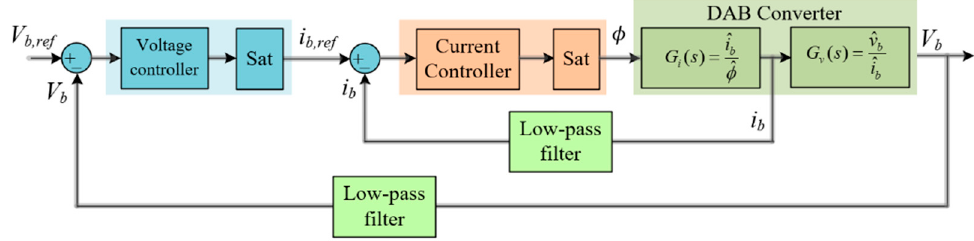
Figure 14. Block scheme of the control loop used to achieve the control tuning of the DAB converter. The open-loop TF of the current-loop G OLi ( s ) has three terms, as shown in Equation (7). G PIi ( s ) is the TF of the current controller and G LPi is the TF of the low-pass filter. G i ( s ) is the TF from phase shift perturbation ˆ φ to the input current perturbation ˆ i b , where V AB is the input voltage between the phase legs of the first full-bridge at a steady state, φ is the phase shift at a steady-state and L LK is the total leakage inductance of the transformer, L LK = L 1 + ( N 1 / N 2 ) 2 L 2 .